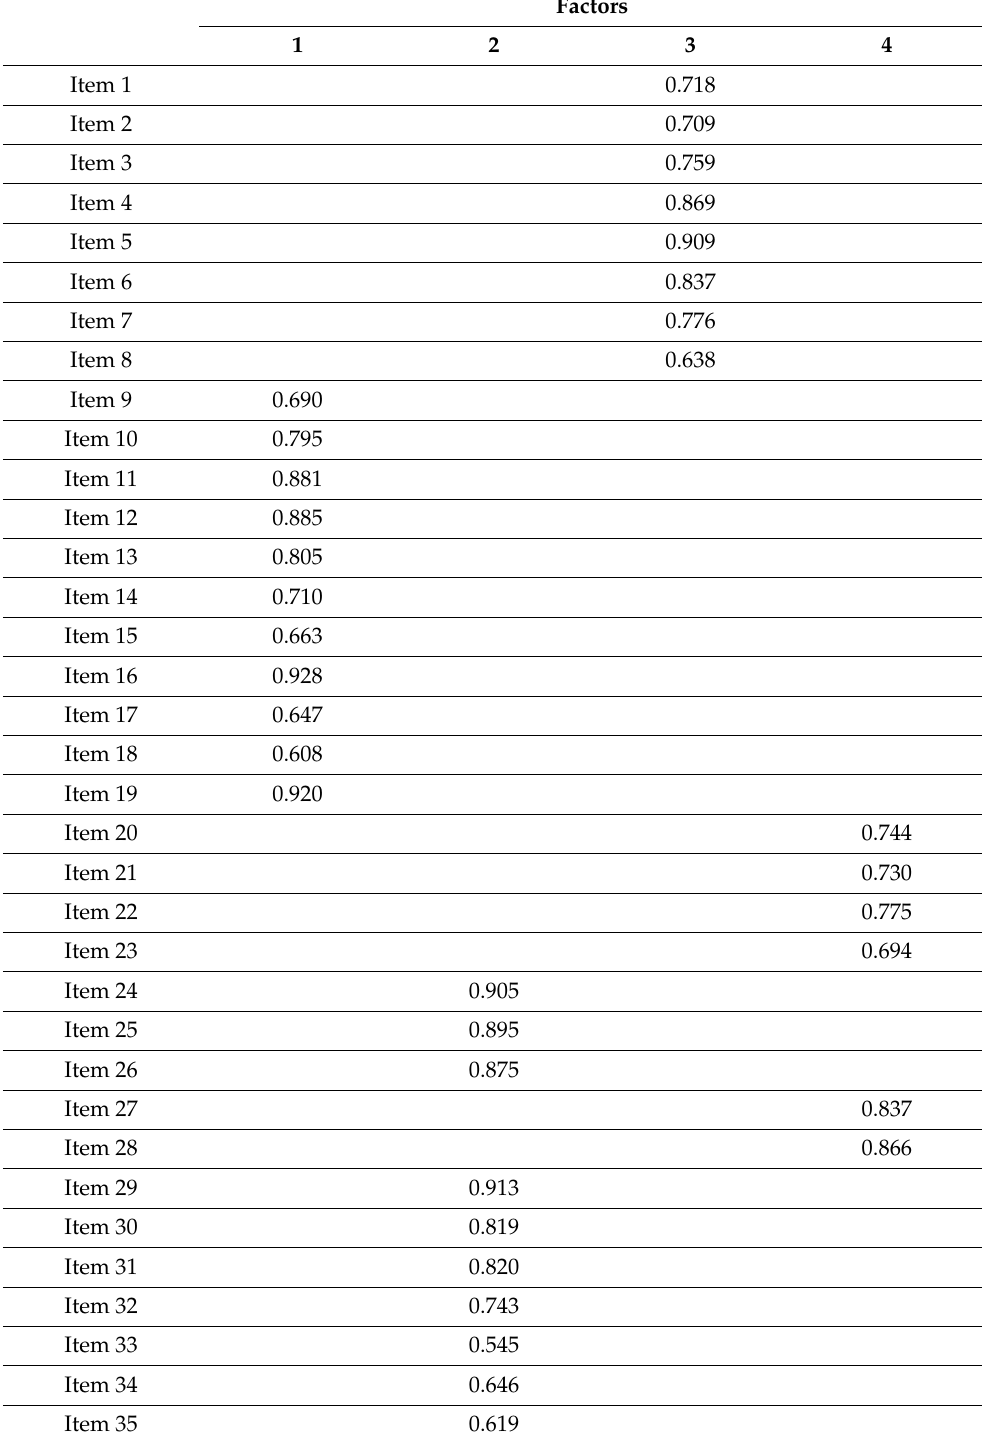
Table 2. Rotated Component